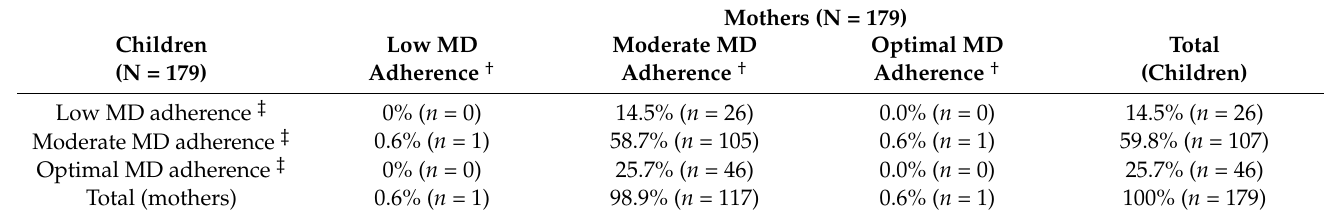
Table 3. Pairs of mothers and children in each MD adherence category (%, n